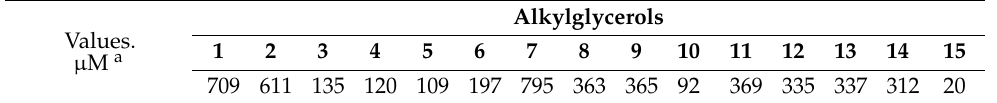
Table 2. Minimum quorum sensing inhibitory concentration ( µ M) of alkylglycerols against C. violaceum ATCC